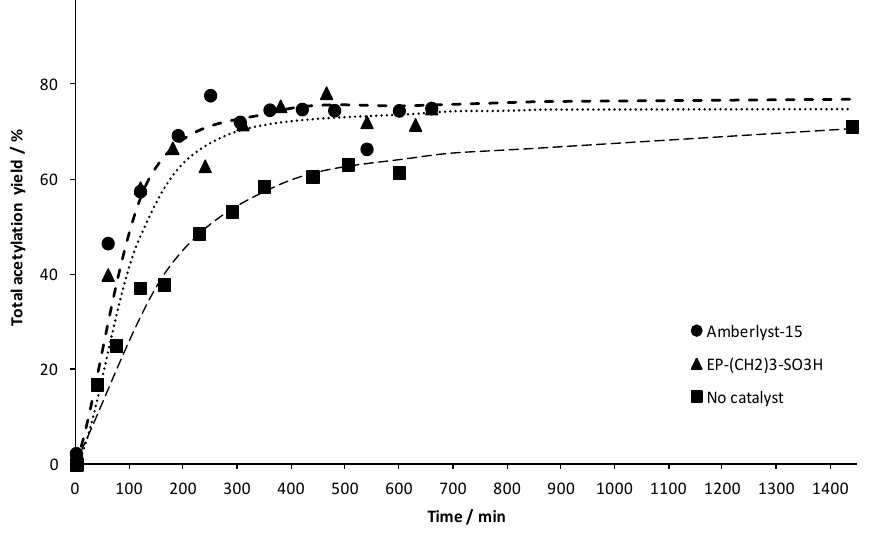
Figure 5. The total acetylation yield for the catalytic reaction with EP–(CH Amberlyst-15. Also the blank reaction is represented for clarity. A catalyst loading